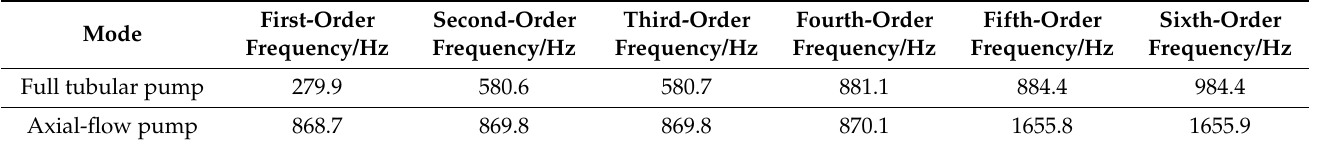
Table 3. Modal natural frequency.